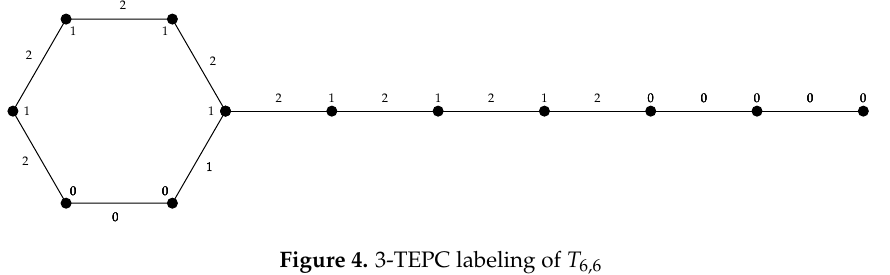
Figure 4. 3-TEPC labeling of T